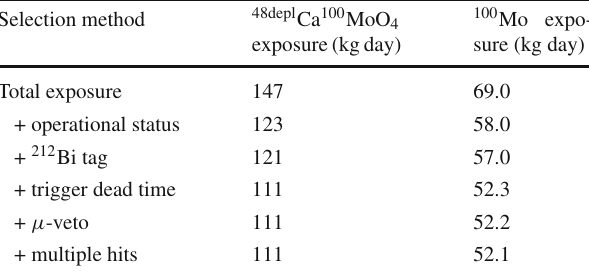
Table 3 48depl Ca 100 MoO 4 and 100 Mo exposure of the AMoRE-Pilot experiment after each event selection method